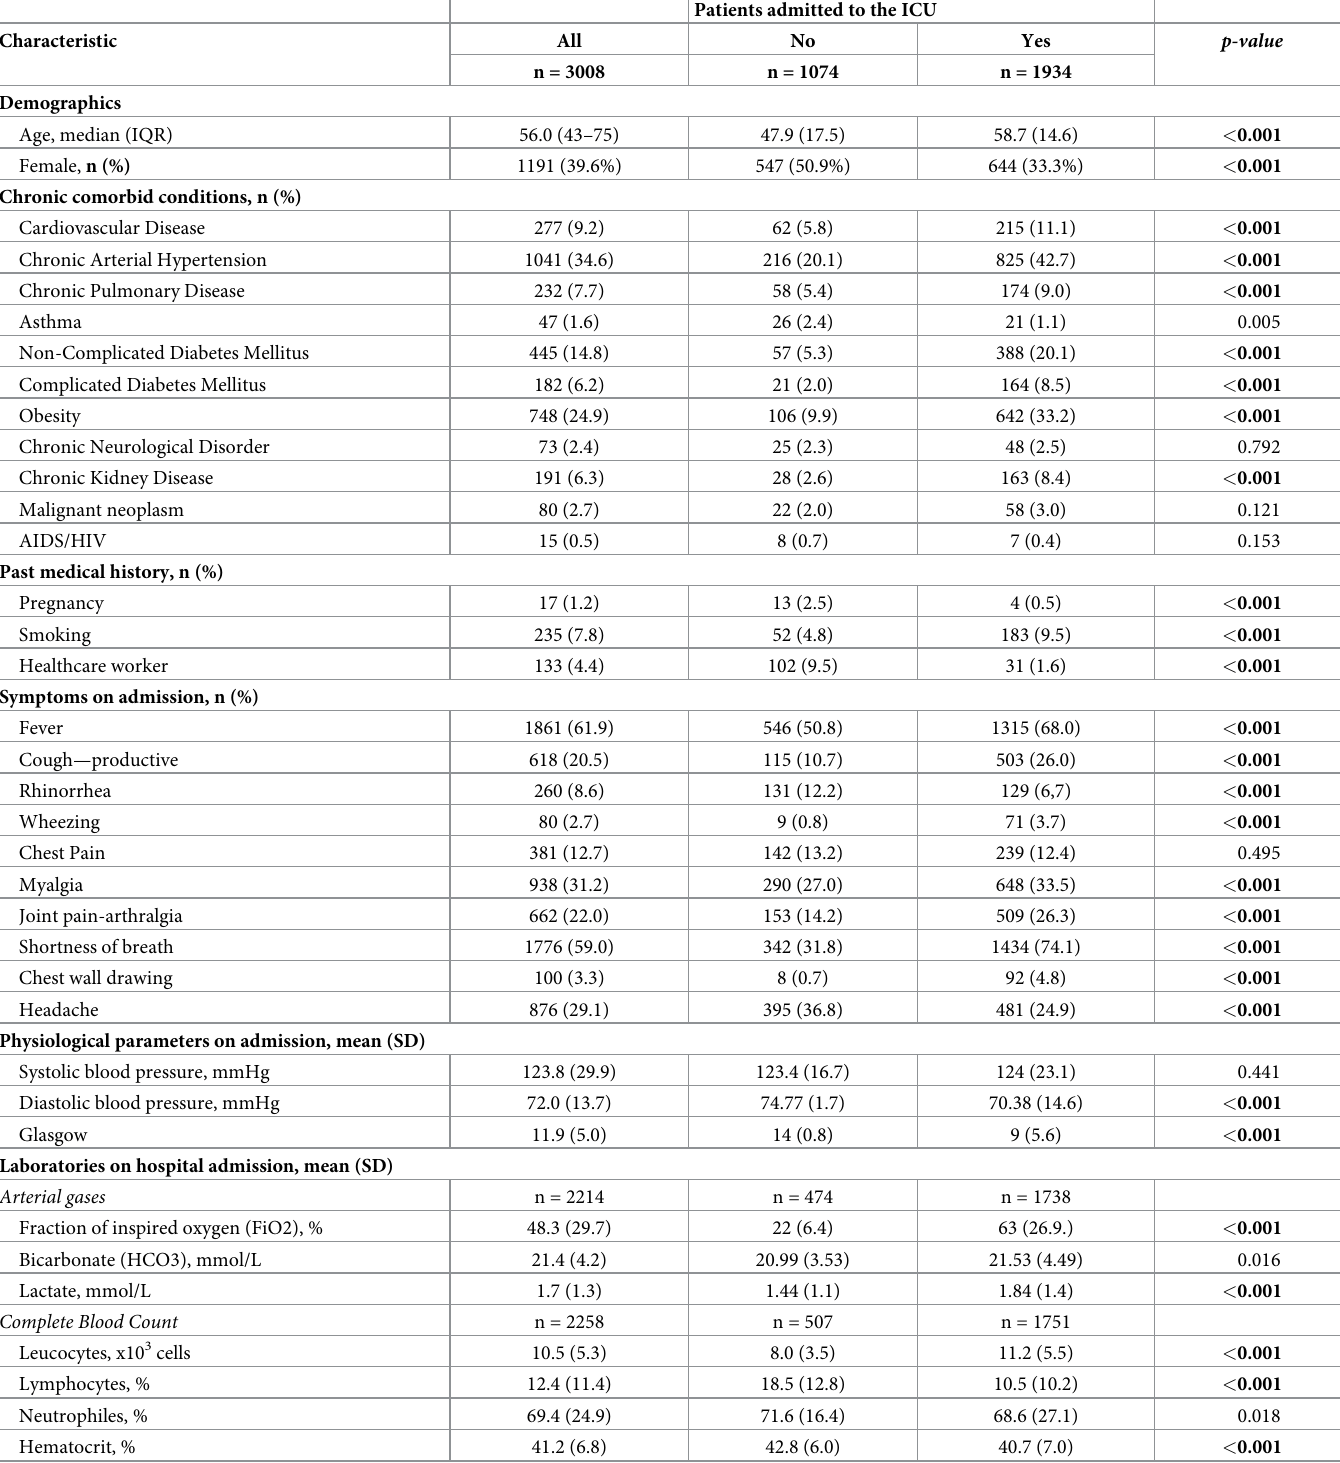
Table 1. Baseline characteristics of patients with confirmed SARS-CoV-2 infection that developed severe COVID-19 stratified by patients admitted to the Intensive Care Unit (ICU).